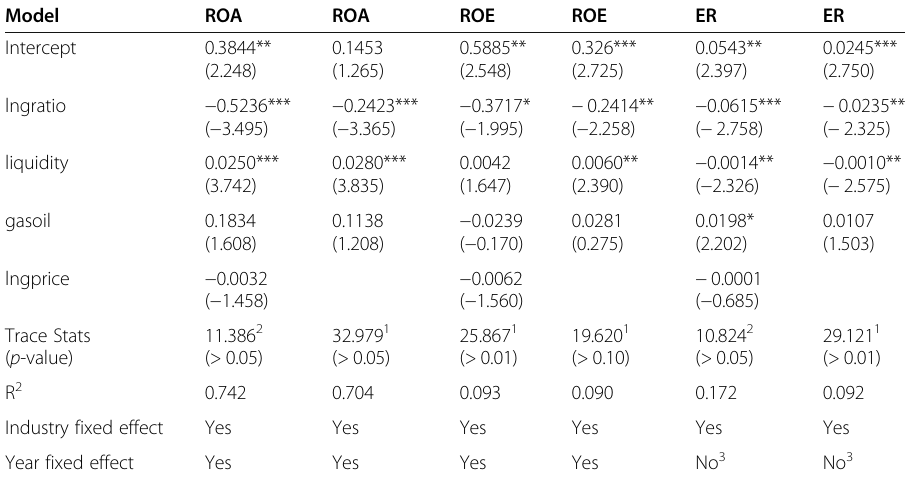
Table 4 Financial performance of 15 shipping firms that originated in LNG carrier business